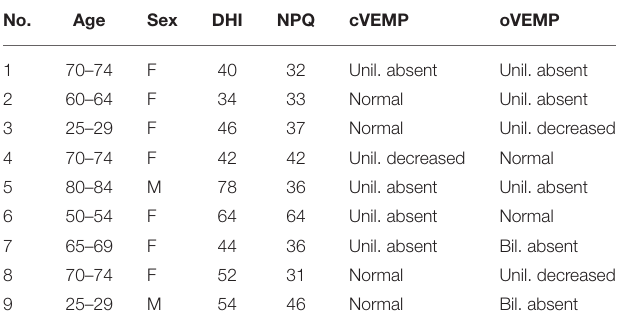
TABLE 1 | Summary of patients with isolated otolith dysfunction.